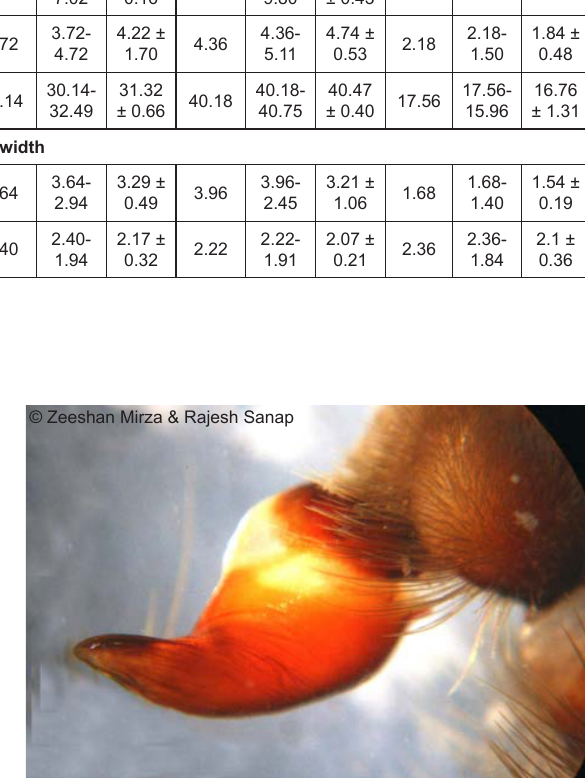
Spinnerets (Fig. 7): Two pairs , yellowish brown covered with golden hair.